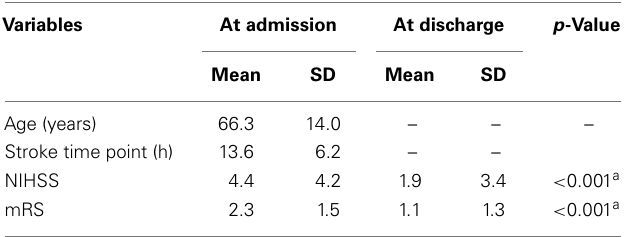
Table 2 | Characteristics of 35 (13 female) stroke patients at admission to and discharge from hospital .